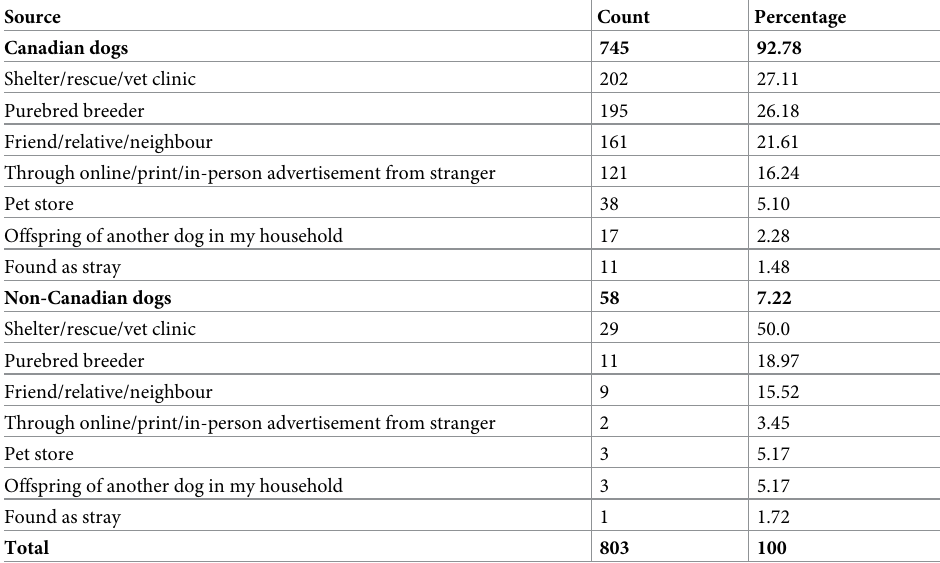
Table 2. Dog source methods.